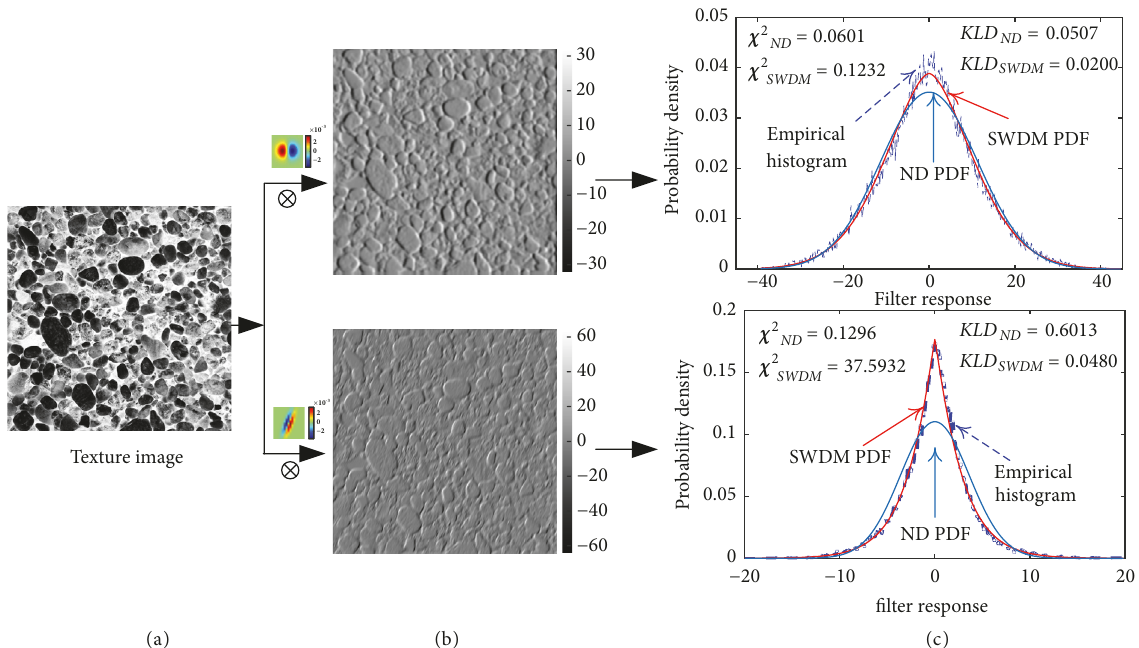
Figure 6: SWDM-based statistical modeling of image spatial structure characteristics. (a) The original texture image, D23 in the Brodatz texture database; (b) the corresponding SSs of D23 with IGDF and AGDF, respectively; (c) SWDM-based statistical modeling results and the fitting results are apparently superior to the normal distribution (ND) estimation results based on the model evaluation indices, statistics 𝜒 2 , and the Kullback-Leibler divergence.